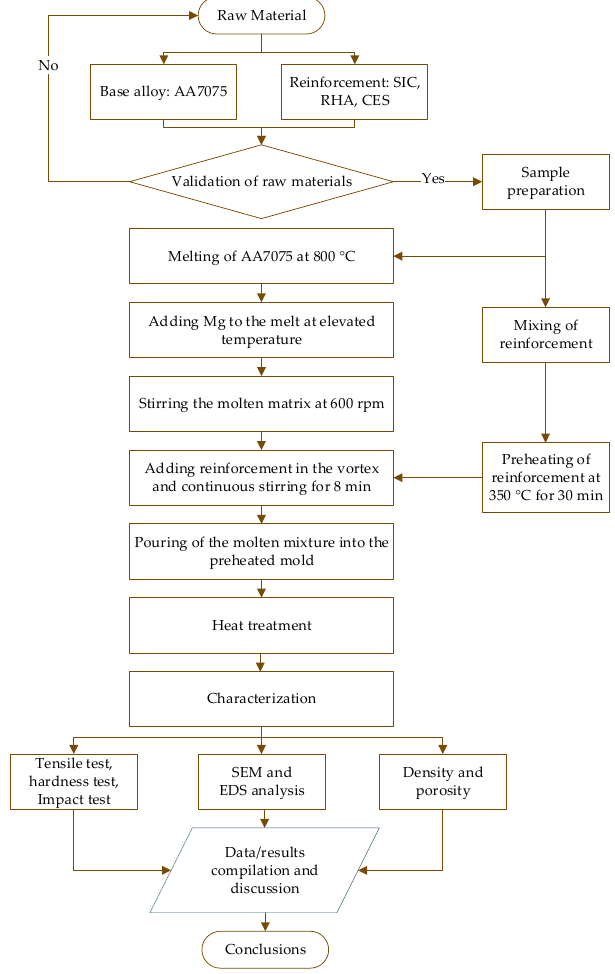
Figure 1. The flow chart of Methodology.